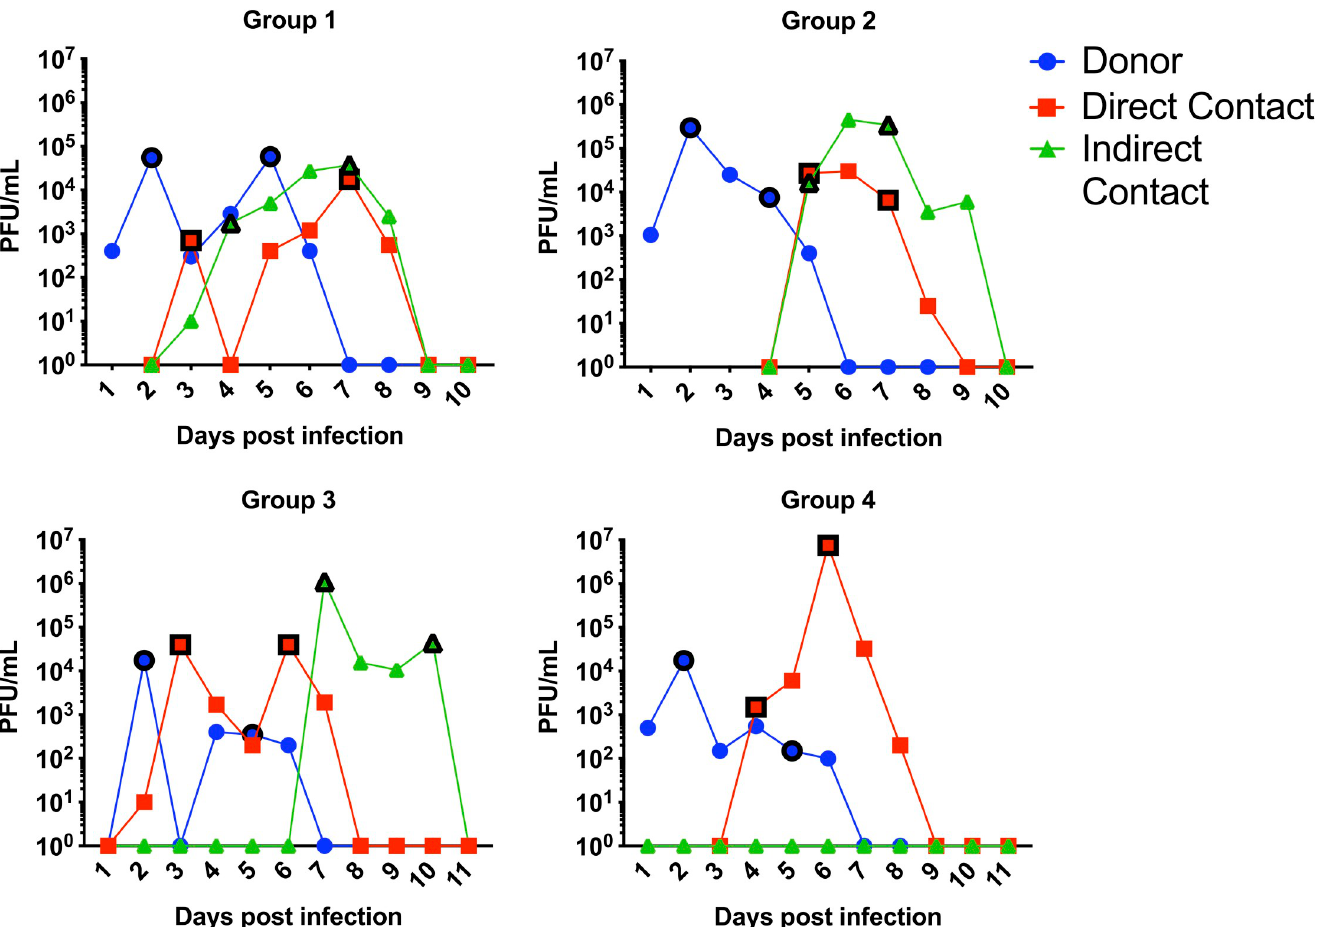
Fig 1. 4 donor ferrets were infected with 10^4 PFU of a virus mix of wildtype Eng195 and K229R+P653L. Direct contact and indirect sentinels were exposed from day 1. Ferrets were nasal washed each day and virus infectivity in nasal wash titred by plaque assay. 2 samples were chosen for sequencing from each ferret and are denoted by the black outlined